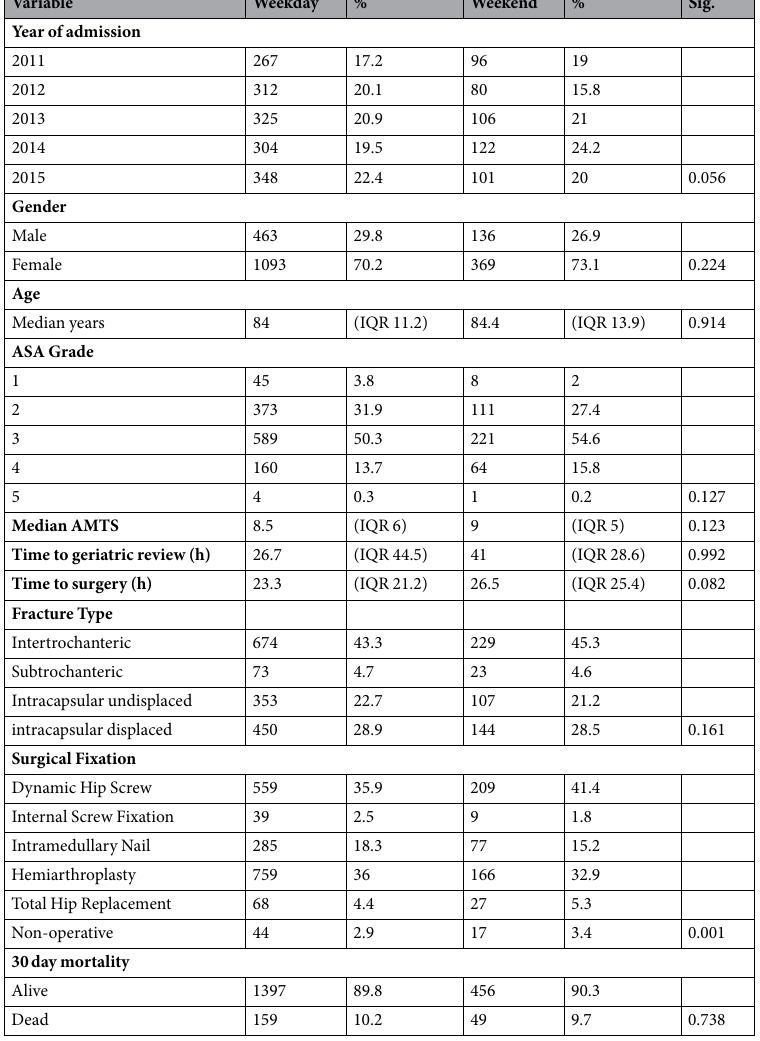
Table 1. The frequency of patient, fracture and treatment variables in patients admitted during a weekday and weekend. Abbreviations: ASA = American Society of Anaesthesiologists, IQR = interquartile range, h =